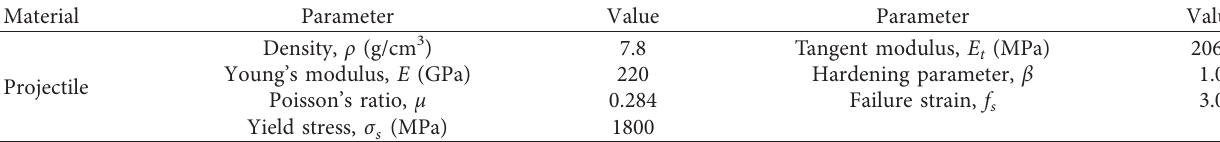
Table 3: Material parameters for projectile.